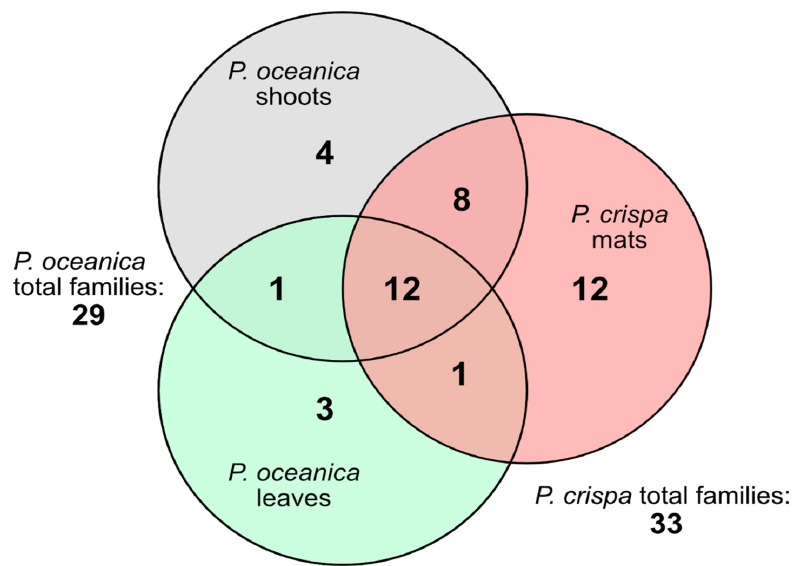
Figure 3. Number of families found per habitat during the second sampling season (2019), showing shared families between the respective habitats.